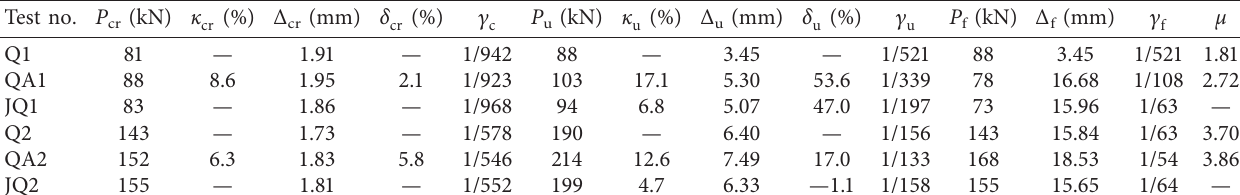
Table 4: Shear capacity of specimens and displacement of the top surface of